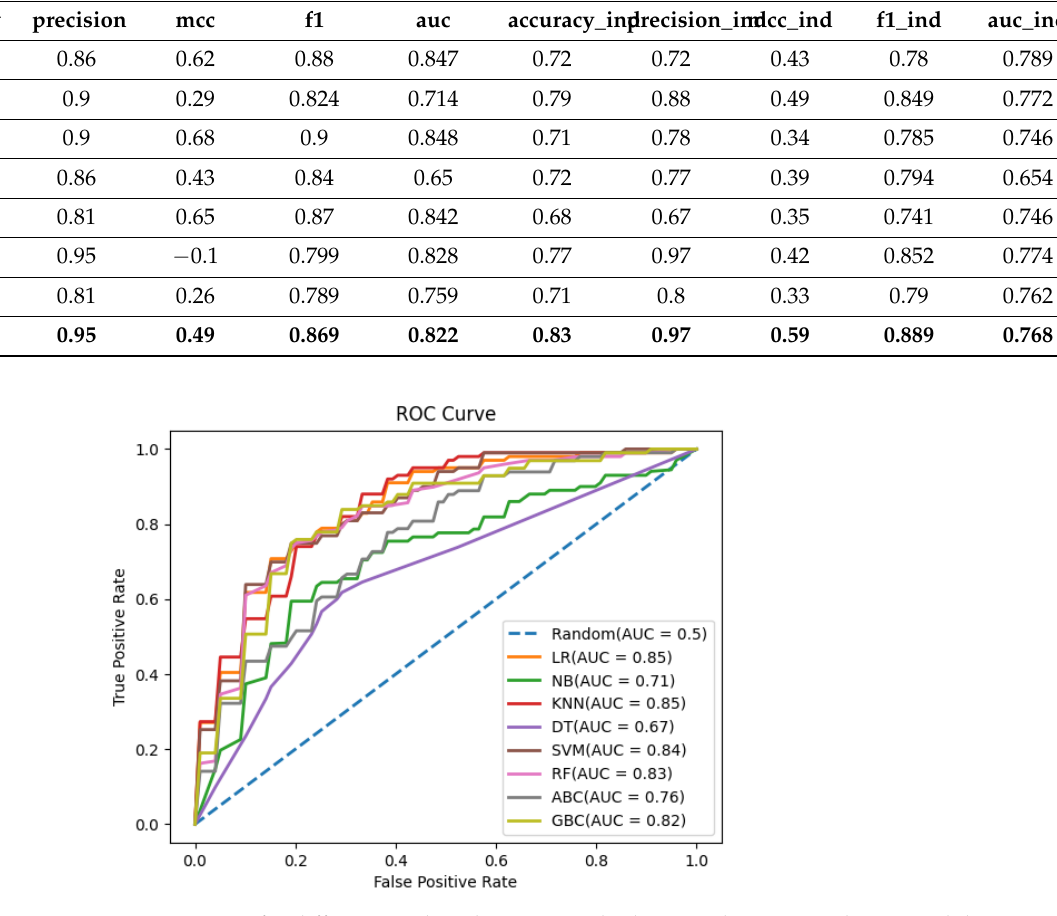
Figure 1. AUC for different machine learning methods using the training dataset and the AAC and DPC features.